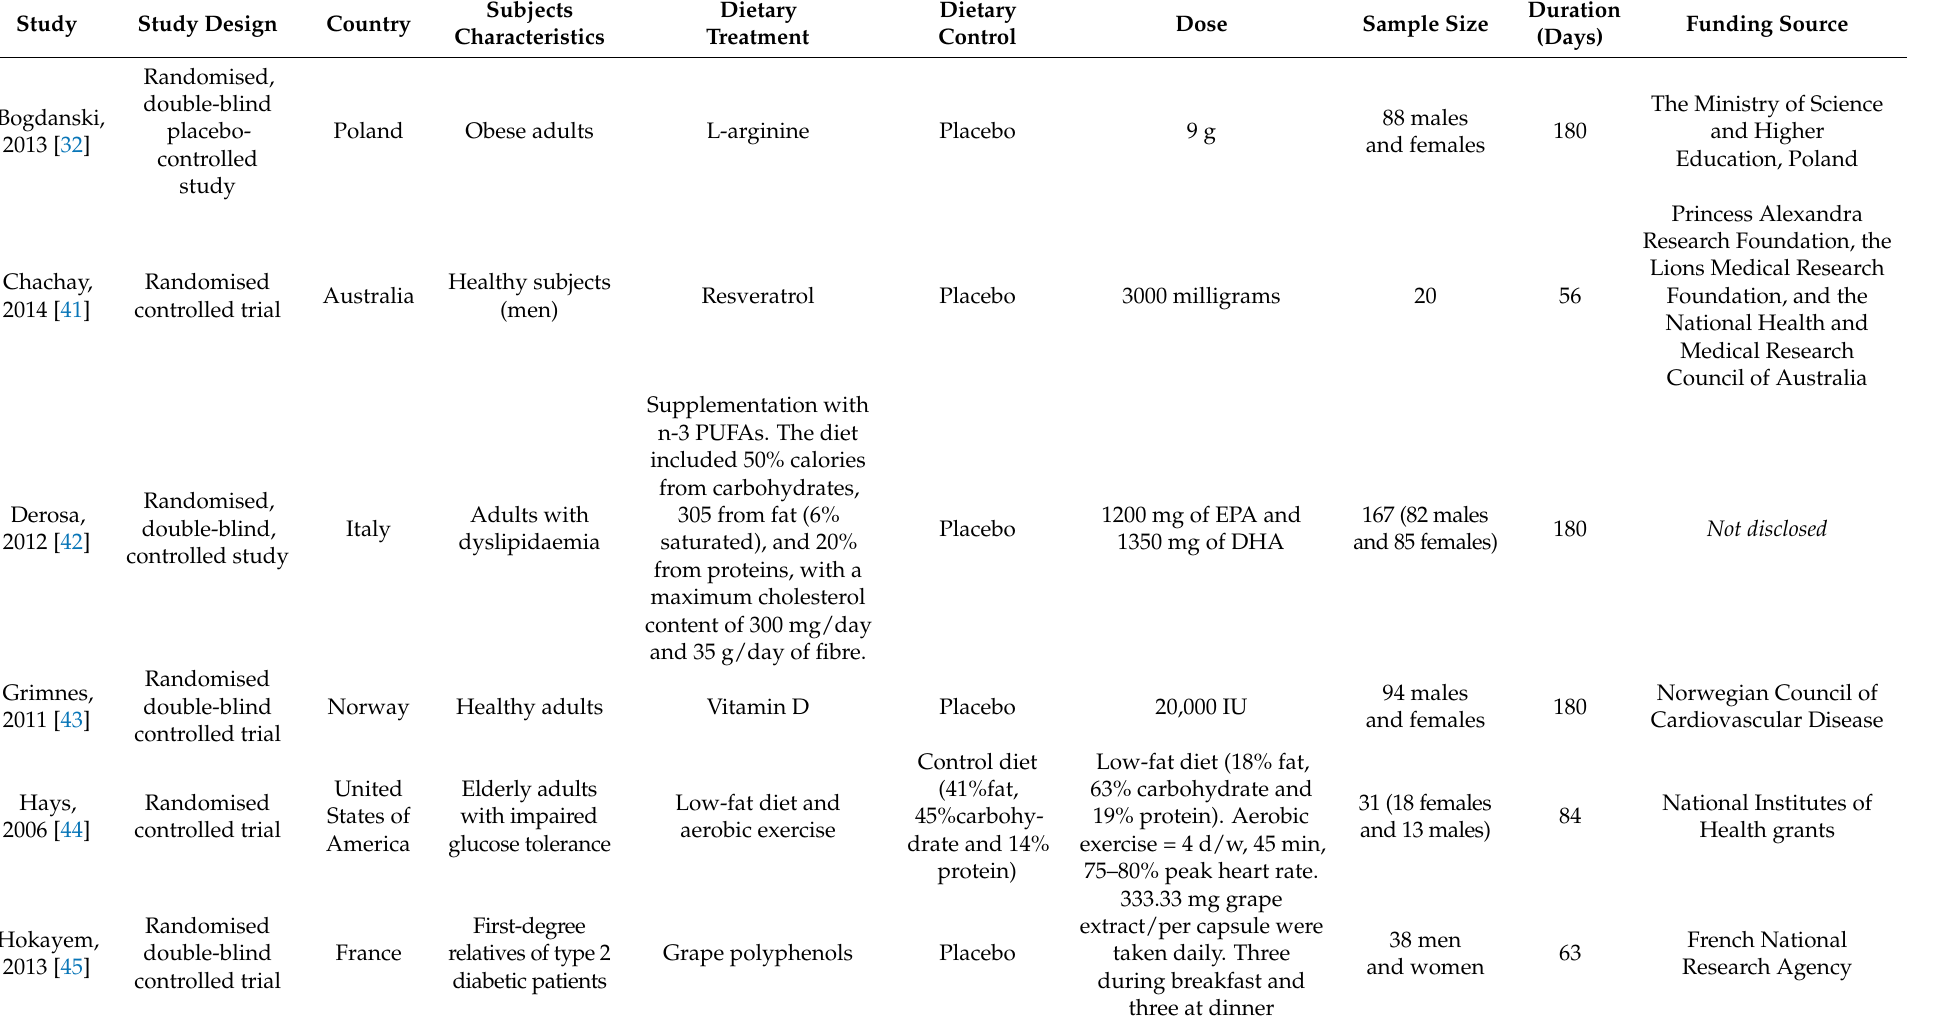
Table 2. Euglycaemic hyperinsulinaemic clamp trials